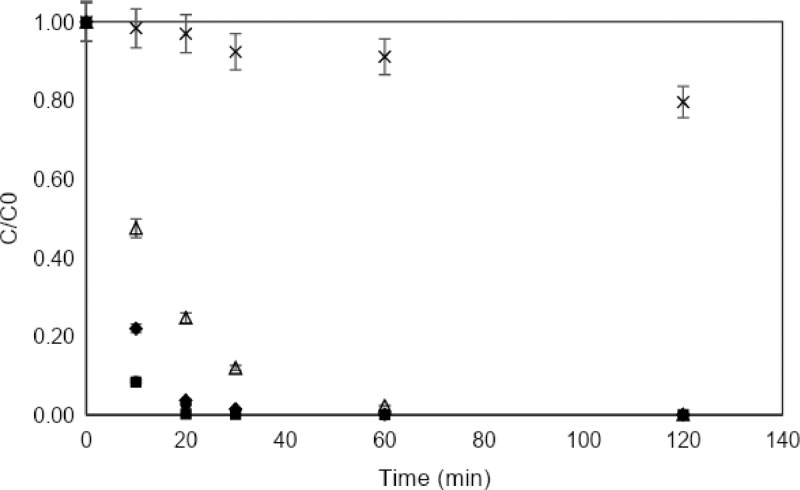
Discoloration of MB under solar simulator at lab test [MB] = 10 ppm, [catalyst]=0.3 g/L.(■) TiO2, (●) TiO2/Fe3O4 (80/20), (♦) TiO2/Fe3O4 (50/50), (∆) TiO2/Fe3O4 (20/80), (×) Fe3O4.